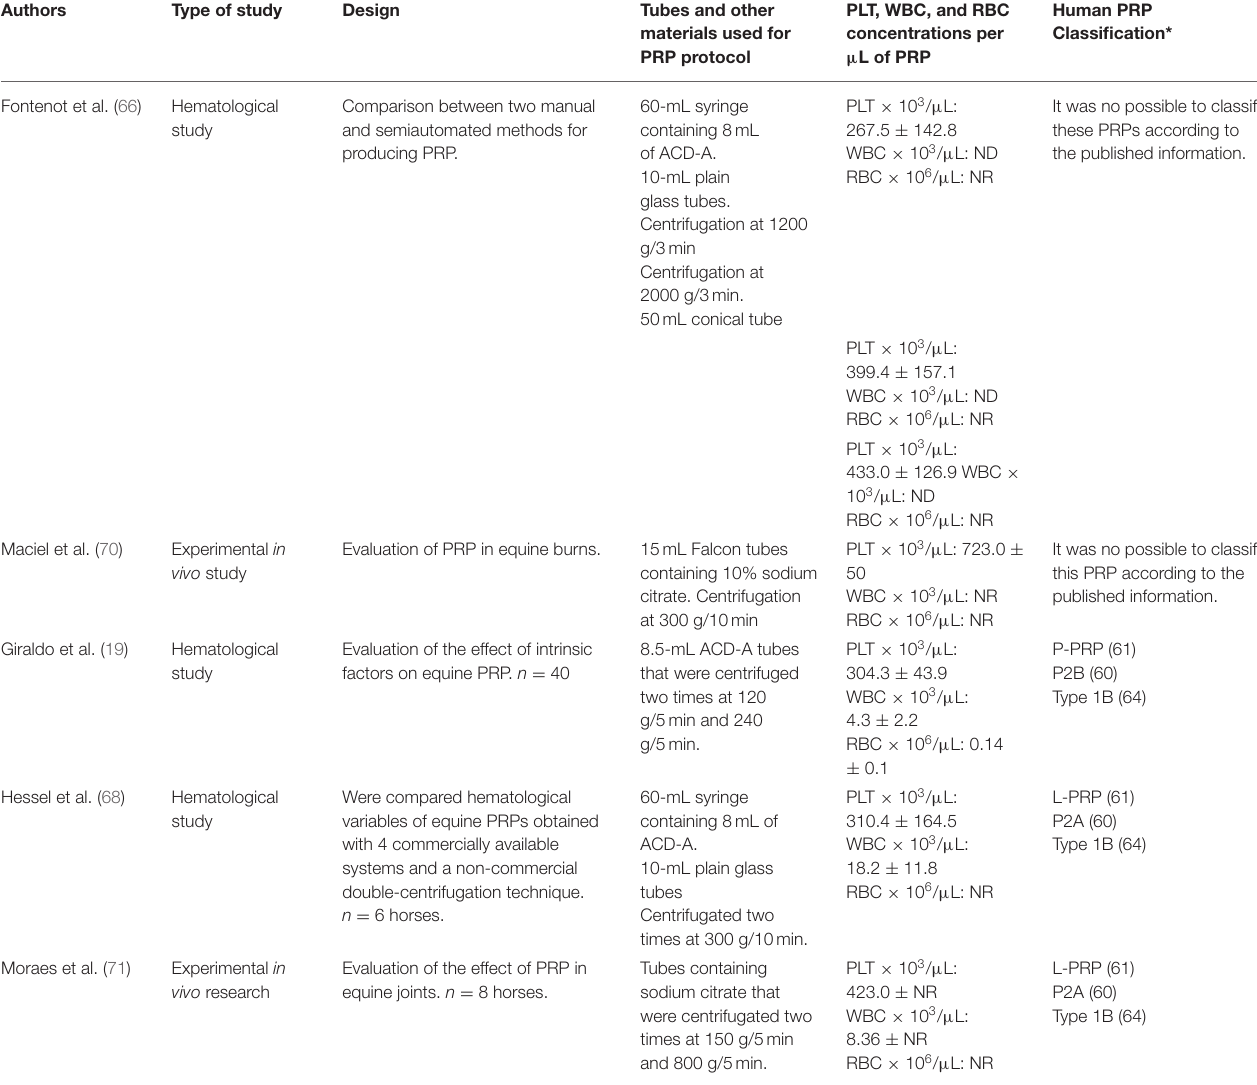
TABLE 3 | Manual methods used for PRP production from equine blood and potential classification according to the systems proposed for human PRP